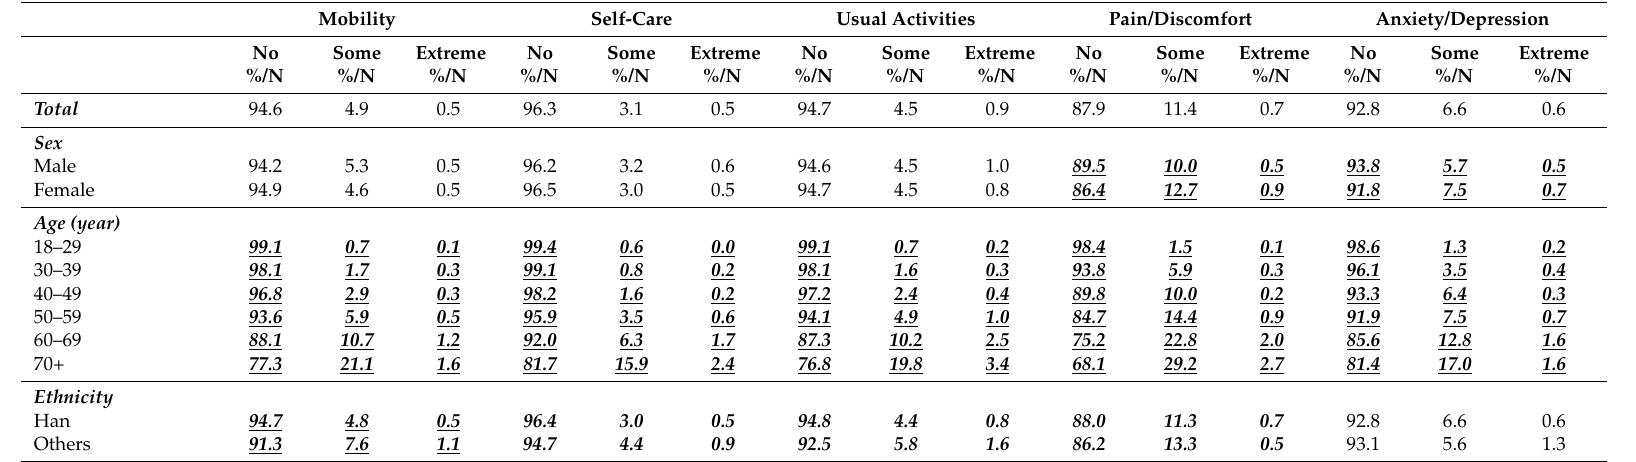
Table 2. Percentage of reported problems in five health dimensions of EQ-5D-3L (N =